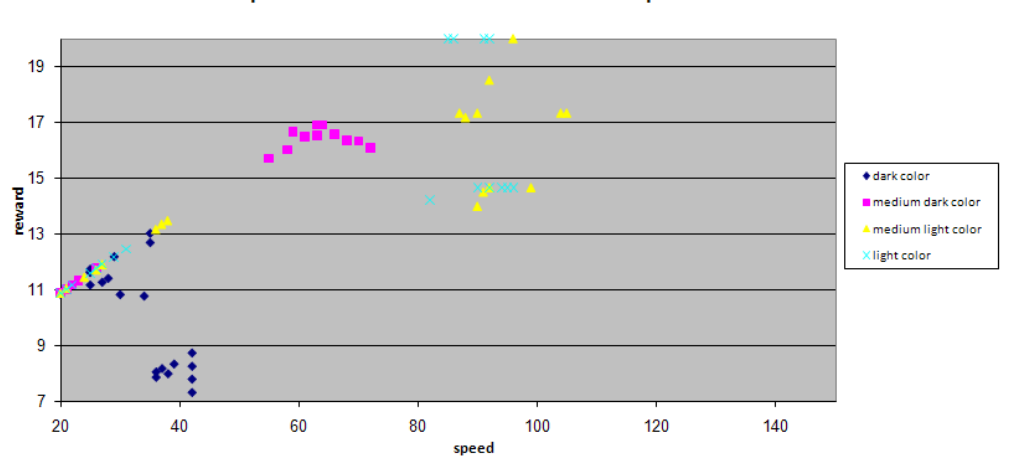
Figure 15. Performance of a cold-tempered robot against its speed when learning from its